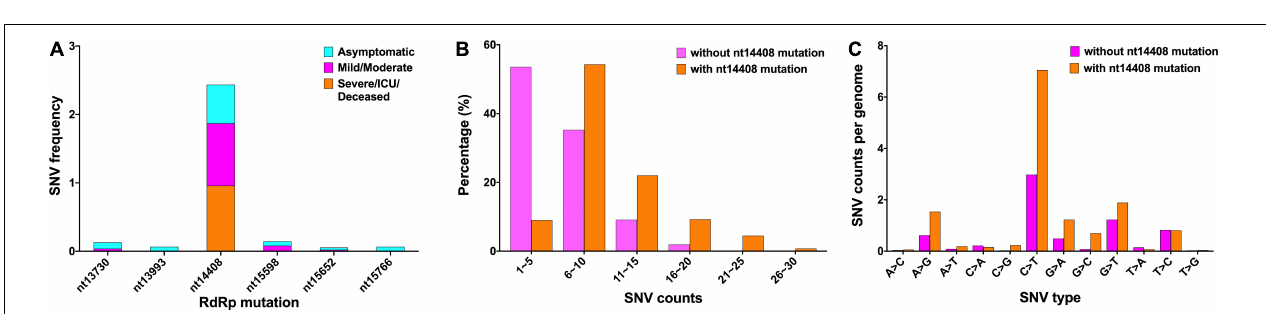
FIGURE 4 | SNVs associated with RdRp mutation in different clinical outcomes. (A) Major mutation sites of RdRp in the three clinical outcomes. (B) Percentage of genome of different SNV count ranges in the “without nt14408 mutation” and “with nt14408 mutation” groups. (C) SNV counts per genome of different SNV types in “without nt14408 mutation” and “with nt14408 mutation” groups. SNV, single-nucleotide variant; RdRp, RNA-dependent RNA